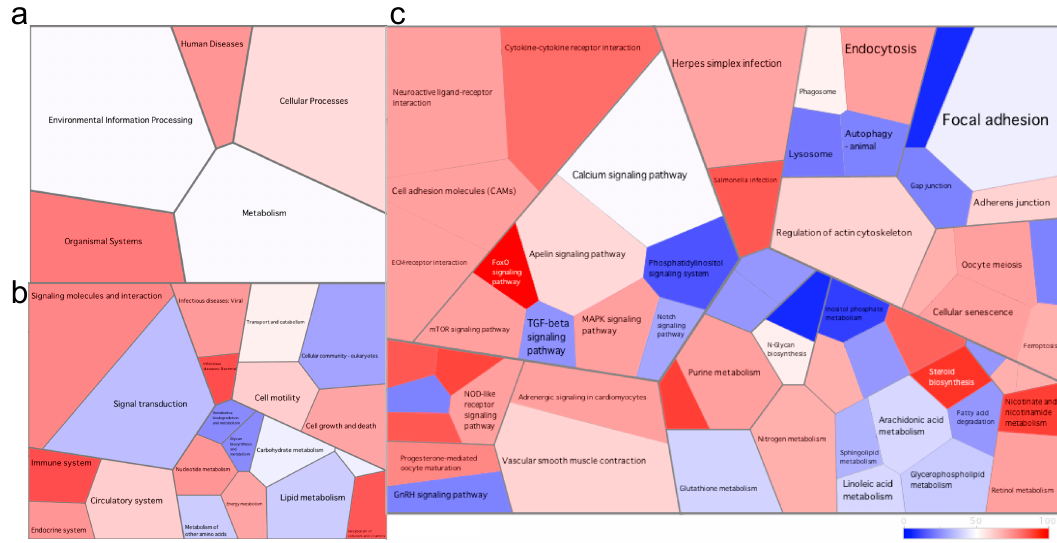
Figure 5. Voronoi tessellation diagrams representing differentially expressed pathways at ( a ) level 1, ( b ) level 2 and ( c ) level 3 of the KEGG database in the skin of the fish at the early stage of the disease. Each polygon represents an ontology term, with their size corresponding to the numbers of genes involved in the associated pathway. To further explore the pathways differentially expressed between health states, we imported all DEGs (and associated logs values) to generate the Voronoi tessellations. Pathways colored in red are upregulated, and those in blue are downregulated in the fish at the early stage of the disease when compared to the healthy fish. A quantile color scale was used to show differential expression.